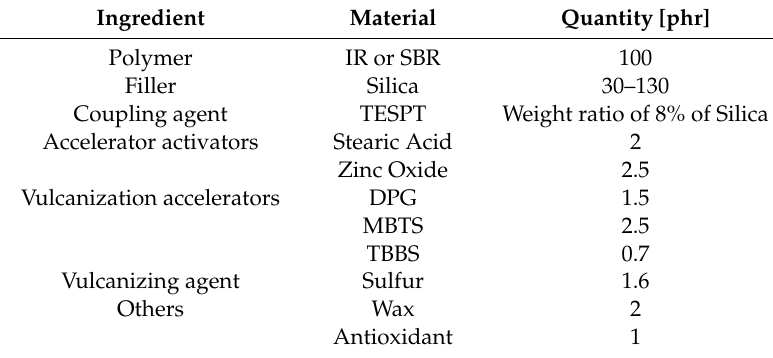
Table 2. Compounding formulation of silica